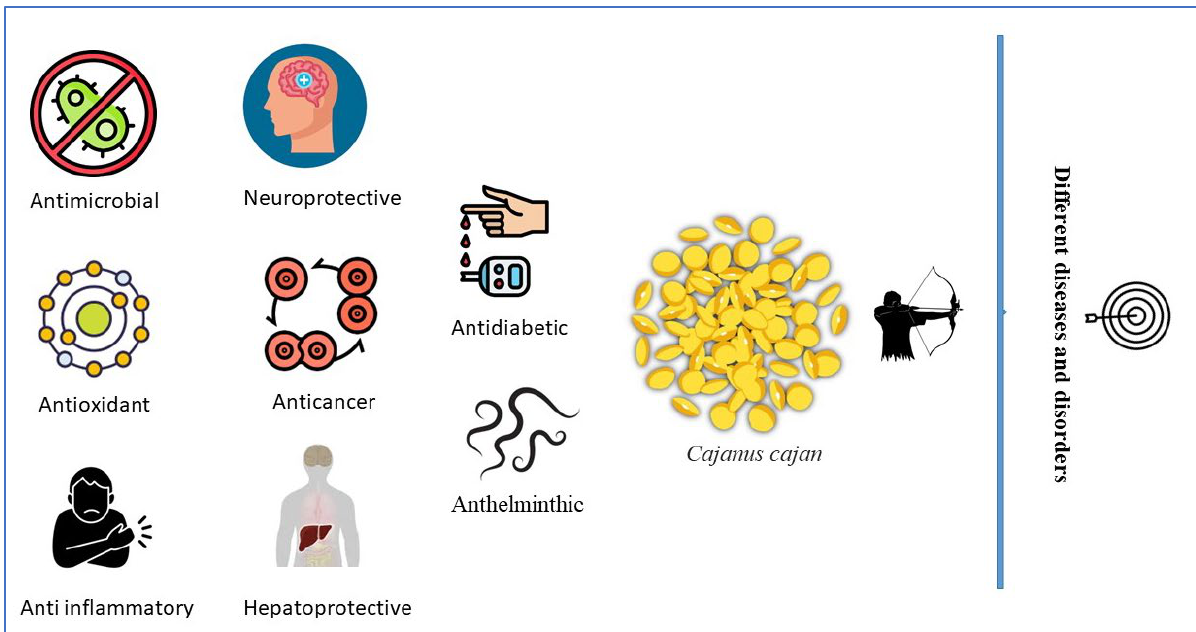
Figure 2. Different biological applications of Cajanus cajan. Table 8. Molecular regulatory mechanism of few biological activities of Cajanus cajan.